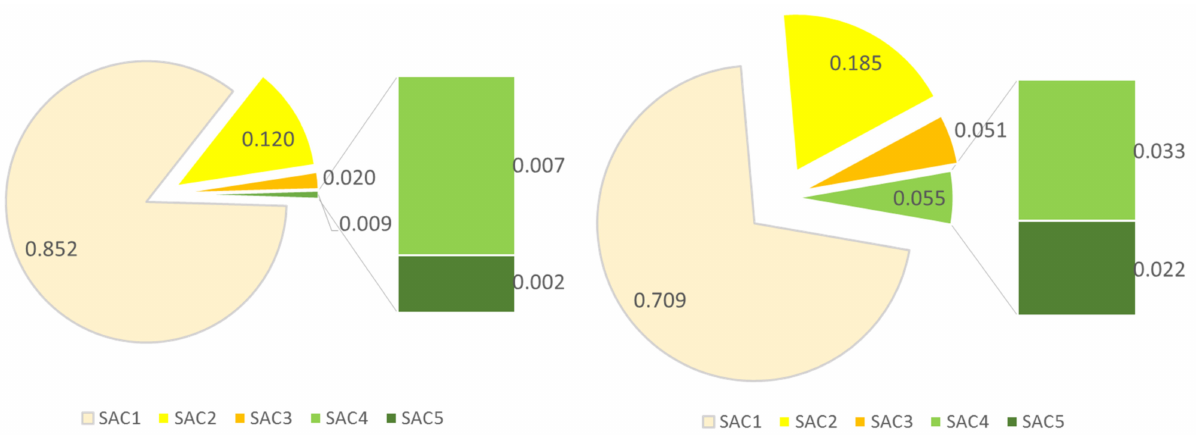
Figure 4. Slope association type—portion of parcels (n~92,000) in Brandenburg, same color scheme as in Table 2.